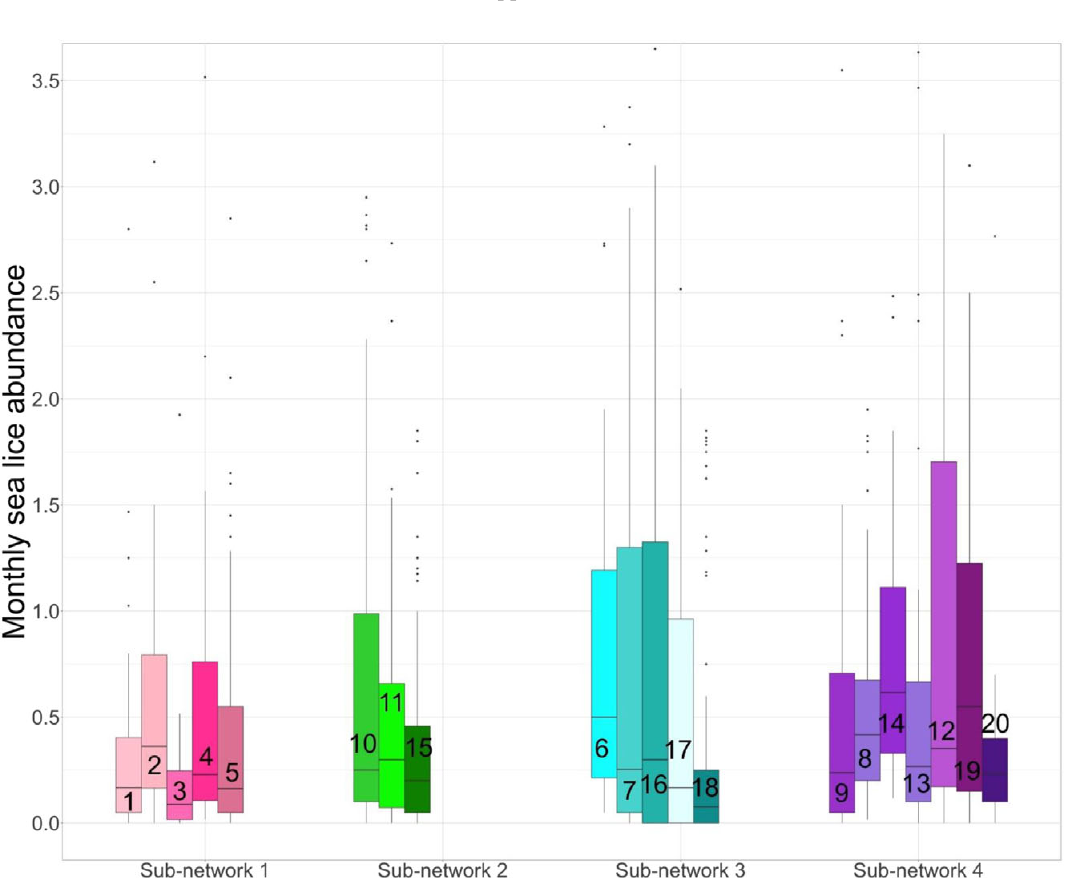
Fig. A1. Monthly motile sea lice abundance for each site, across all years (2005−2017). Box plot for motile sea lice abundance counts, from 2005−2017, arranged by sub-network identified in the simulation study. The bisecting line in the boxes is the median. Note that while the y -axis is only shown to 3.5 sea lice fish −1 in order to show the details of the boxplots themselves, just under 10% of all monthly values were in excess of this level with around half of these outlier values occurring in 2005 and 2006. Numbers on boxes correspond to Farm no. (see Fig.